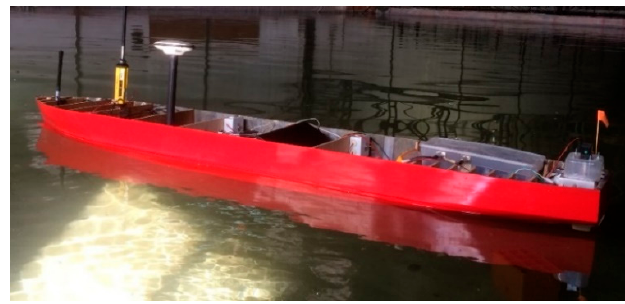
Figure 3. A scaled free-running chemical tanker.